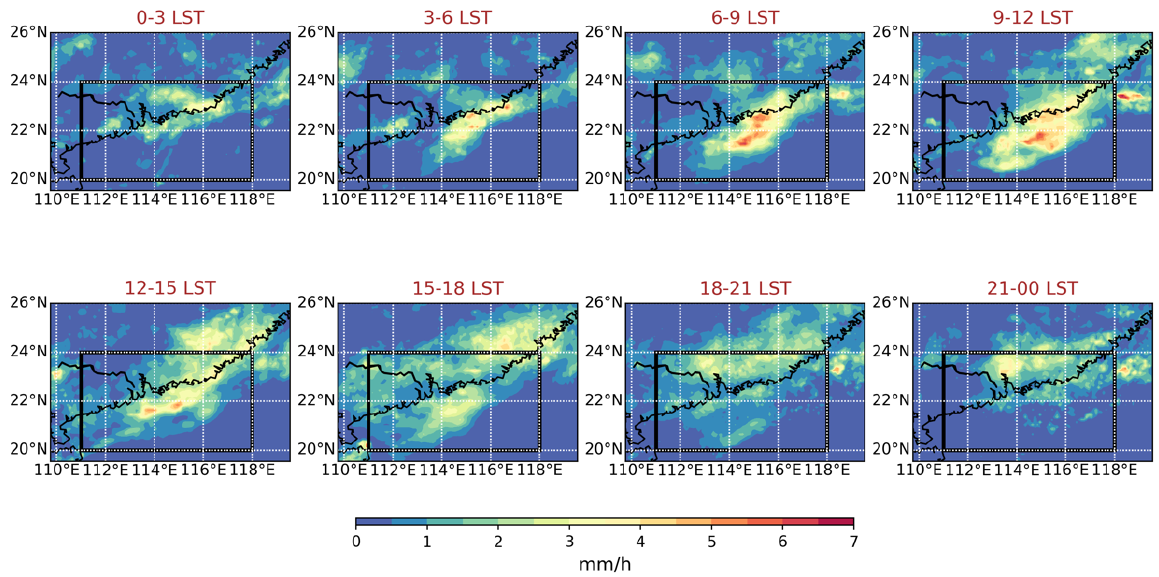
Figure 2. Three- hourly mean rainfall evolution (shown on the map) based on IMERG data. Days were selected from June 2017. The region highlighted with a black box is the SCCA, the area of focus